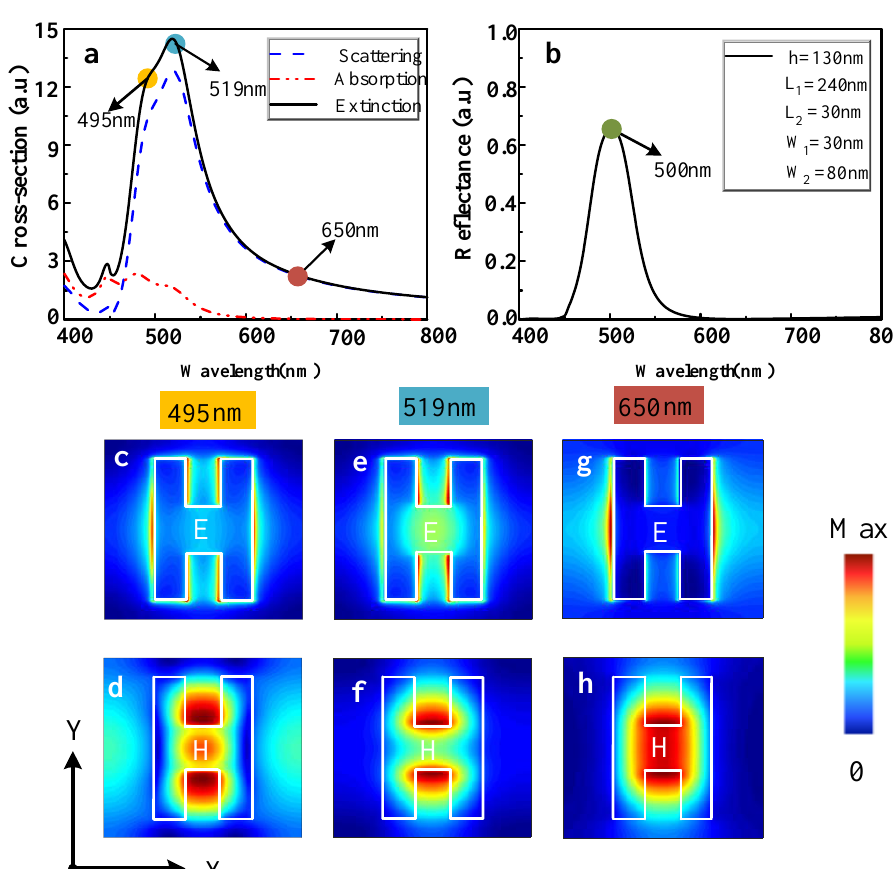
Figure 2. ( a ) The simulated scattering, absorption, and extinction cross-section. ( b ) The simulated reflectance spectrum. ( c – h ) The calculated distribution of electric and magnetic fields at wavelengths of 495 nm, 519 nm, and 650 nm, with structural parameters h = 130 nm, L 1 = 240 nm, L 2 = 30 nm, W 1 = 30 nm, and W 2 = 80 nm.